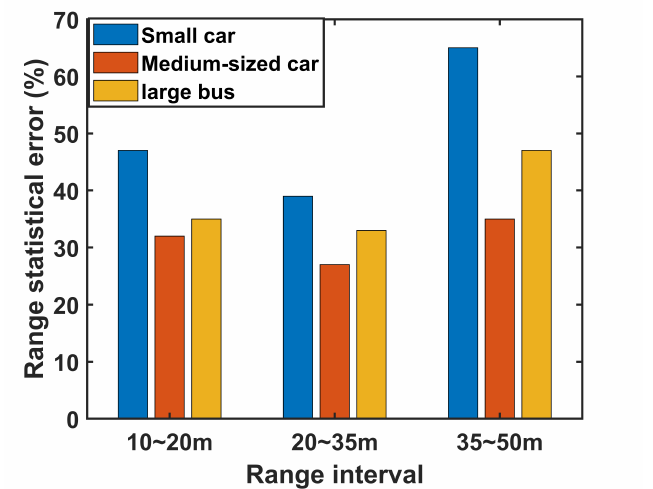
Figure 28. Length estimation